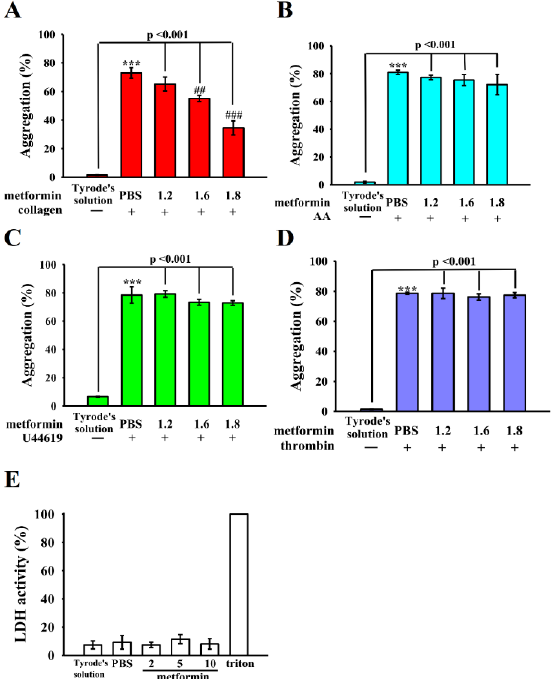
Figure 1. Effect of metformin on platelet aggregation upon stimulation with agonists and lactate dehydrogenase (LDH) release. Washed human platelets (3.6 × 10 8 cells/mL) were preincubated with a solvent control (PBS) or metformin (1.2, 1.6, and 1.8 mM) and treated with collagen (( A ), 1 µ g/mL), arachidonic acid (AA; ( B ), 60 µ M), U46619 ( C ), 1 µ M), and thrombin (( D ), 0.05 U/mL) to trigger platelet aggregation. ( E ) To evaluate the cytotoxic effect of the metformin on the human platelets, the platelets were pretreated with solvent control (PBS) or metformin (2, 5, and 10 mM) or the positive control (0.5% Triton) for 20 min, and 10 µ L of the supernatant was dropped on a Fuji Dri-Chem slide LDH-PIII. Data are presented as mean ± standard error of the mean ( n = 4). *** p < 0.001 vs. the resting group (Tyrode’s solution); ## p < 0.01 and ### p < 0.001 vs. PBS + collagen